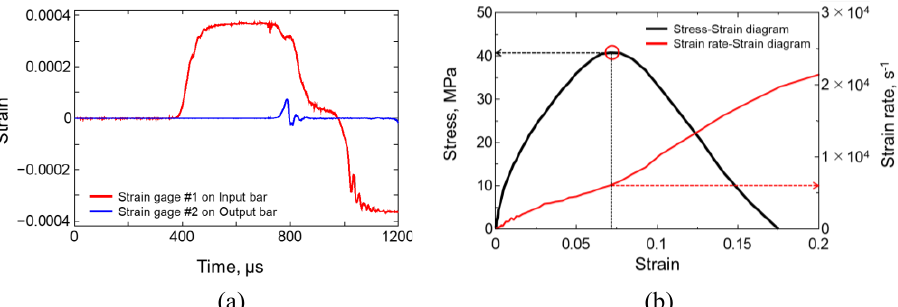
Fig. 3. The results of transition strain at each strain gage (a) and stress-strain and strain rate-strain curves (b). Table 1. Conditions and results for each test